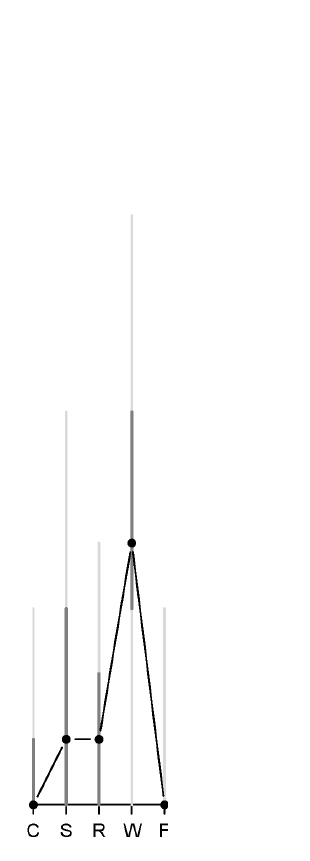
Figure 6. Centrality (betweenness) of each item in the network as a function of level of neuroticism in the validation dataset. Low, mid, and high neuroticism are shown from left to right. The labels of the items are abbreviated by their first letter (C=cheerful, S=sad, R=relaxed, W=worry and F=fearful). The black dots are the model-based estimate of betweenness, the darkgrey vertical lines represent 50% confidence intervals and the light grey vertical lines represent 95% confidence intervals (as estimated from the bootstrap method). Together, the median, 50% and 95% confidence intervals give information on how the node centrality for every item in all three networks is distributed.